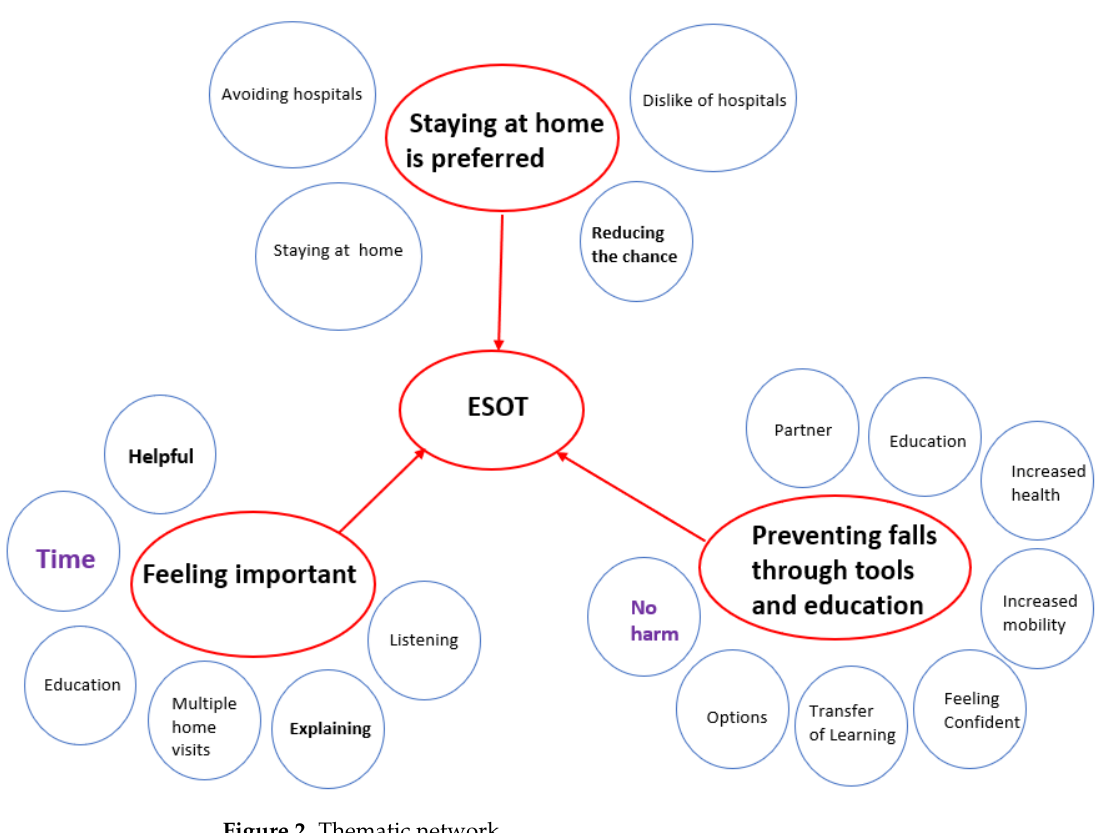
Figure 2. Thematic network.